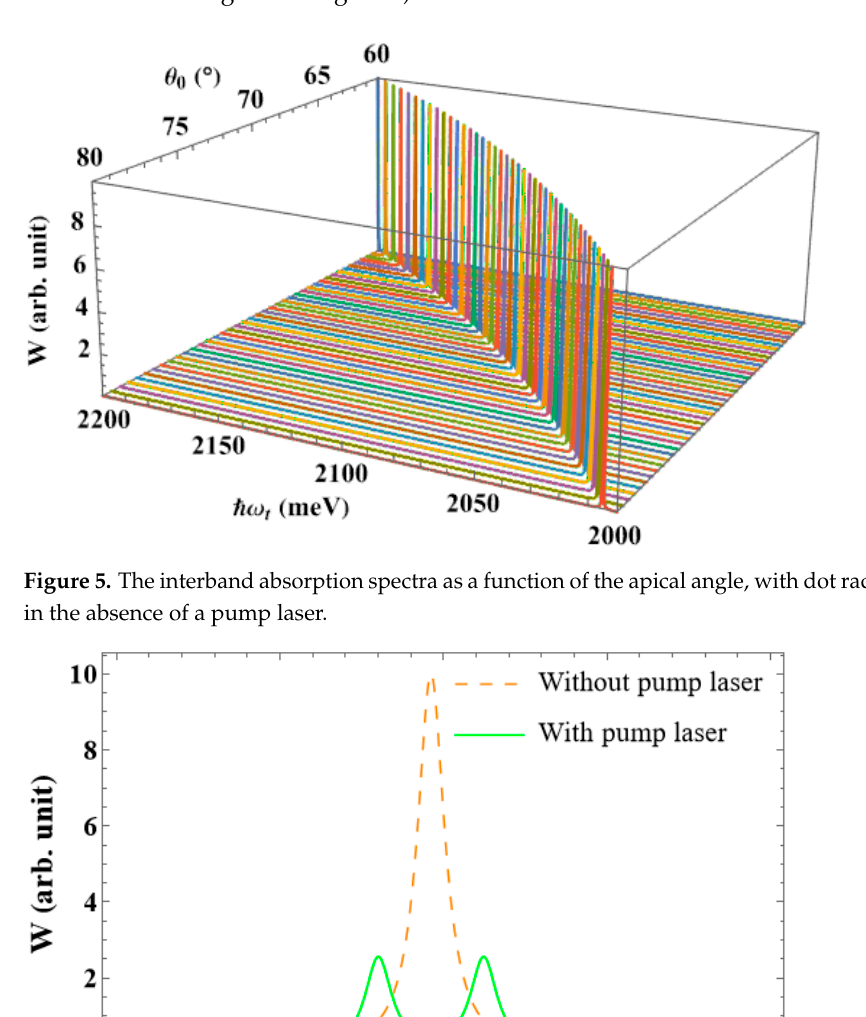
Figure 6. The interband absorption spectra without a pump laser, and with a pump laser that has the detuning  0 meV w D = . detuning (cid:125) ∆ ω = 0